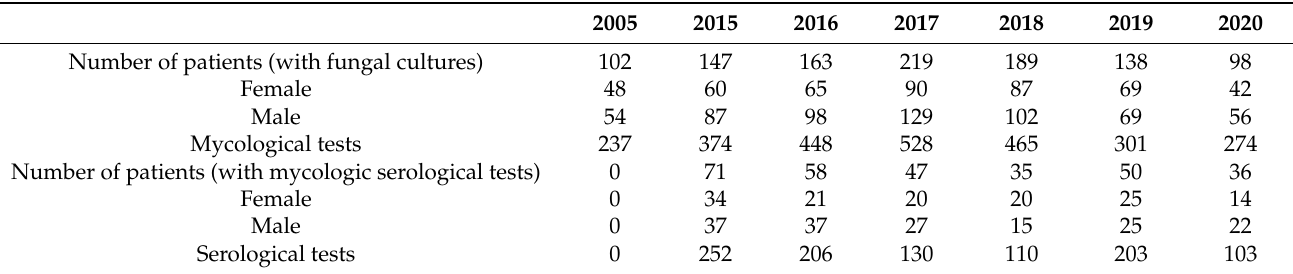
Table 1. Mycological tests in PCICU